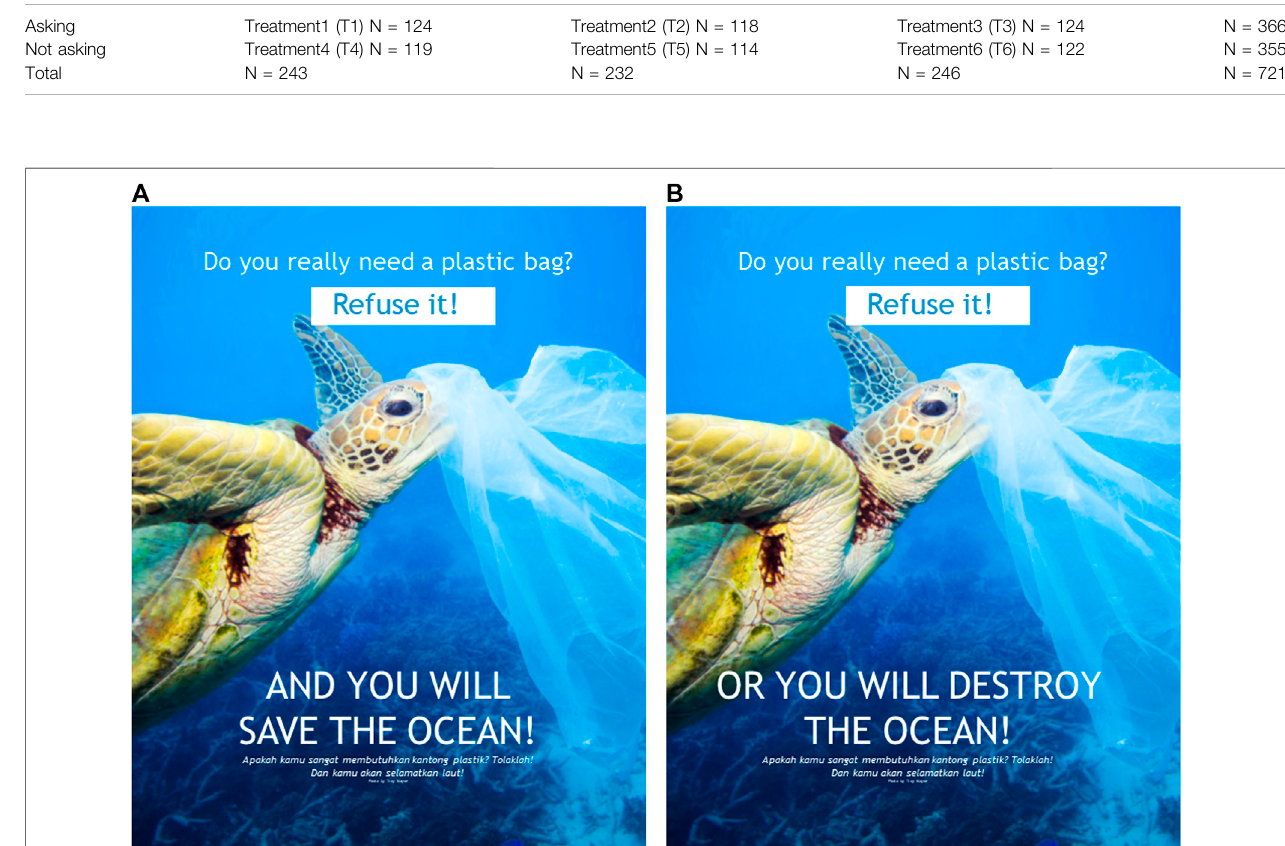
FIGURE 2 | Positively (left) and negatively (right) framed signs that were placed on the store ’ s counter.